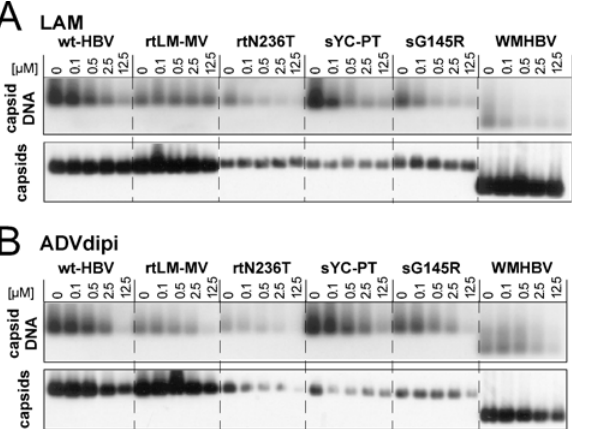
Fig 3. Simultaneous detection of capsid-associated DNA and capsids by NAGE blotting suggests cytotoxicity of long-term stored ADV dipivoxil. Cell lines for the indicated HBV variants and WMHBV were treated with LAM or a long-term stored ADV dipivoxil (ADVdipi) preparation. Equal aliquots from cytoplasmic lysates were separated on 1% agarose gels and blotted onto Nylon membranes (for capsid DNA) or